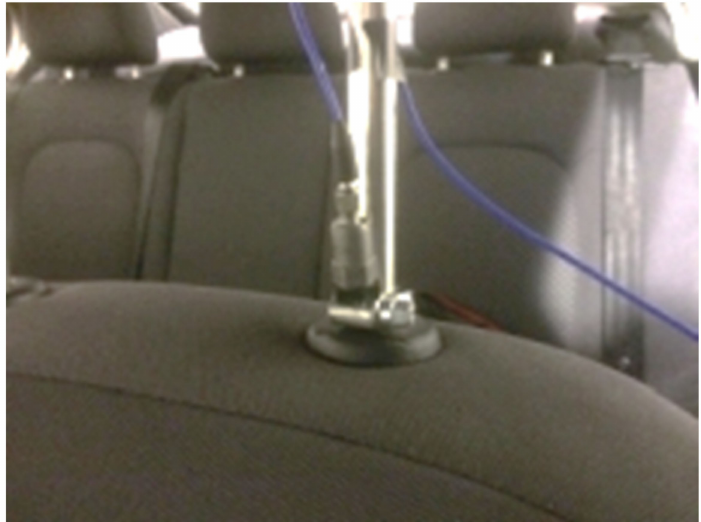
Figure 3. The sensor mounted on the driver’s headrest